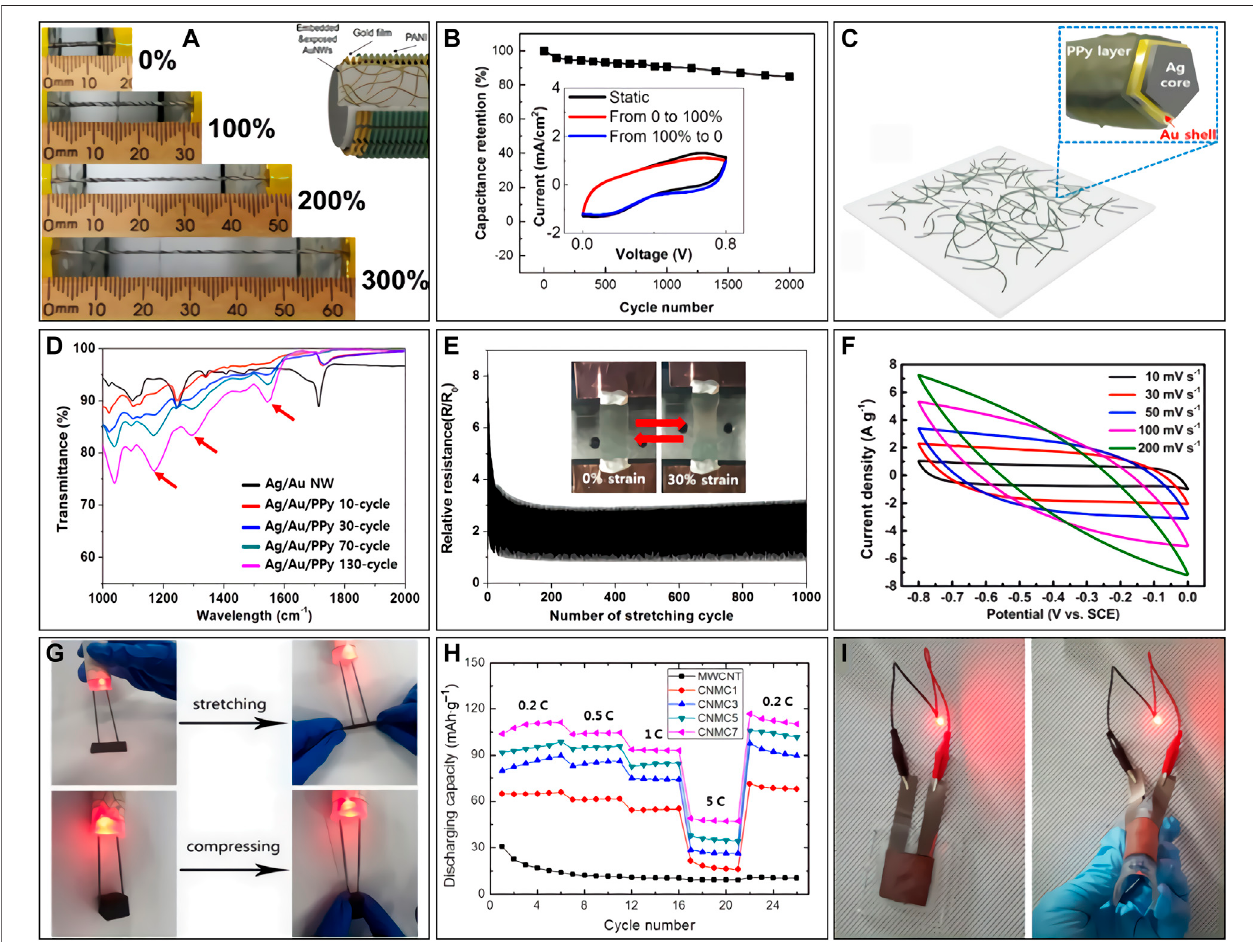
FIGURE 2 | (A) Photographs of a stretchable fi ber-based supercapacitor at strains of 0, 100, 200, and 300%, respectively. The inset images show the schematic illustration for the structure of the Au NWs/Au Film/PANI fi ber electrode. (B) Capacitance retention of the stretchable fi ber-based supercapacitors during 2000 cycles of 0%-200%-0% stretching/releasing. The inset shows the CV curves of the stretchable fi ber-based supercapacitors in static status (black curves), stretching from 0% to 100% strain (red curve) and releasing from 100% to 0% (blue curve) at a fi x scan rate of 100 mV s − 1 . Adapted from Zhao et al. (2018) with permission. Copyright 2018 American Chemical Society. (C) Ag/Au/PPy core-shell NW mesh fi lm produced by electropolymerization of pyrrole. (D) FT-IR spectrum of Ag/Au and Ag/Au/PPy core-shell NW samples with different amounts of PPy. (E) The strain-dependent relative electrical resistance of Ag/Au/PPy core-shell NW mesh for 1,000 stretching cycles. Insets show the digital image of the electrical resistance measurement test of Ag/Au/PPy core-shell NW on a polydimethylsiloxane (PDMS) substrate. Adapted from Moon et al. (2017) with permission. Copyright 2017 Springer Nature. (F) CV curves of the as-fabricated supercapacitors were recorded at different scan rates ranging from 10 to 200 mV s − 1 . (G) Lighting photo of an LED with an externalpower supply connected by the conductive Cu NWs-MWCNT foam during stretching and compression.AdaptedfromWangetal.(2021)withpermission. Copyright2021ElsevierB.V. (H) TheratecapabilityofCuNWs-MWCNTandMWCNT anodesinthefull cell with a polypropylene (PP) separator, LiPF 6 electrolyte, and LiFePO 4 /MWCNT cathode. (I) Red LED powered by a fl exible LIB. Adapted from Yin et al. (2018) with permission. Copyright 2018 Springer